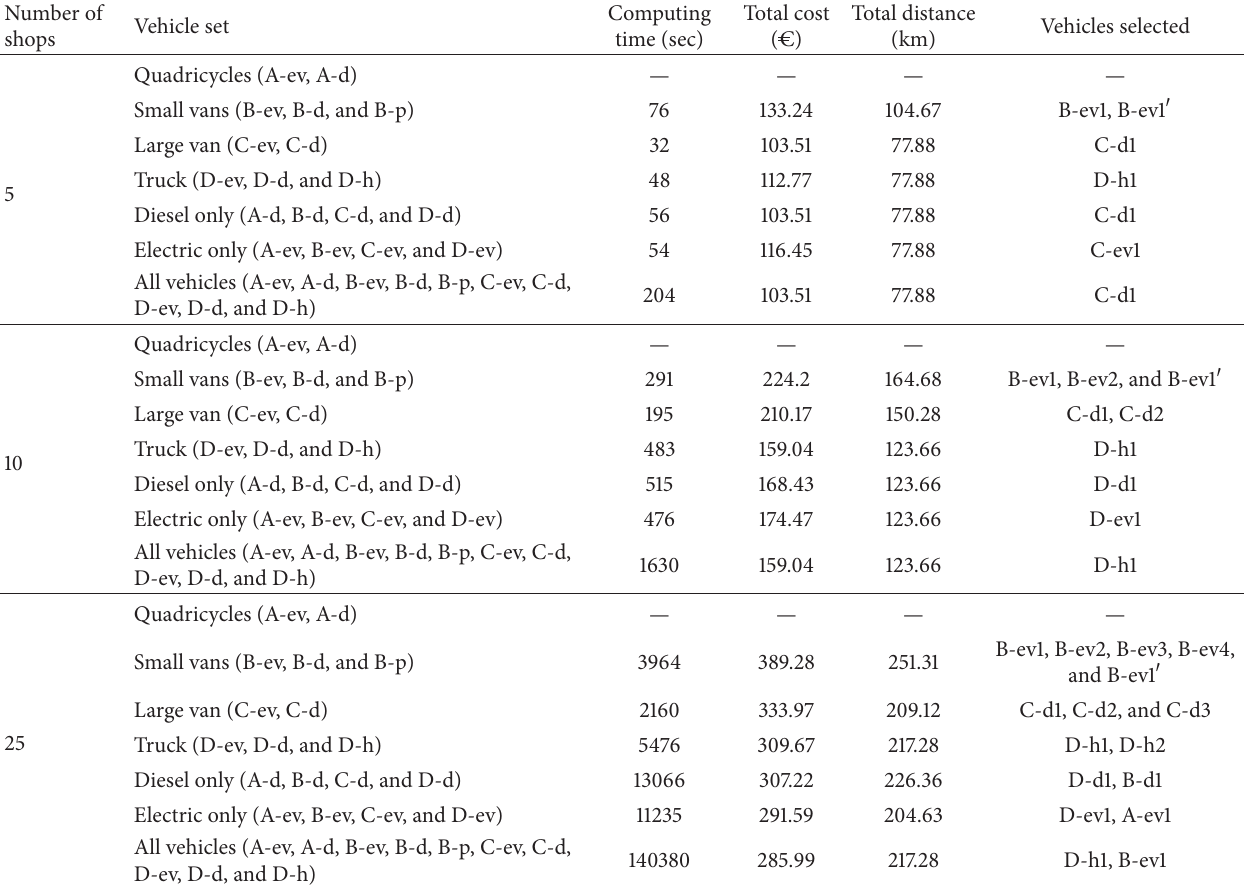
Table 2: Results of the